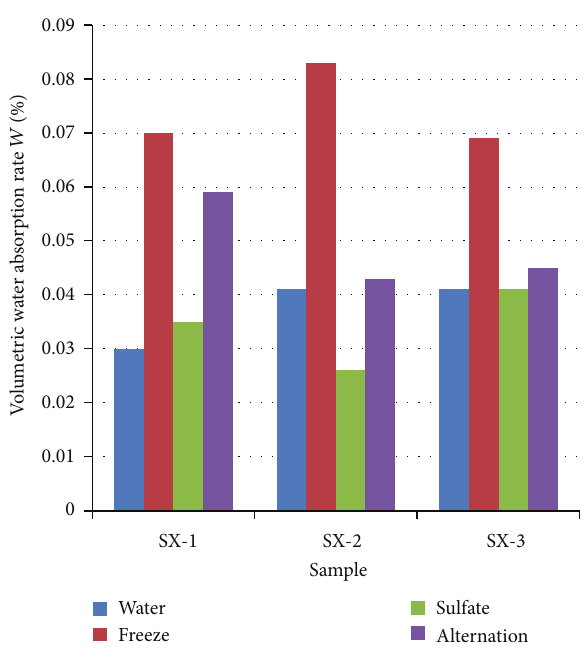
Figure 1: Volumetric water absorption of